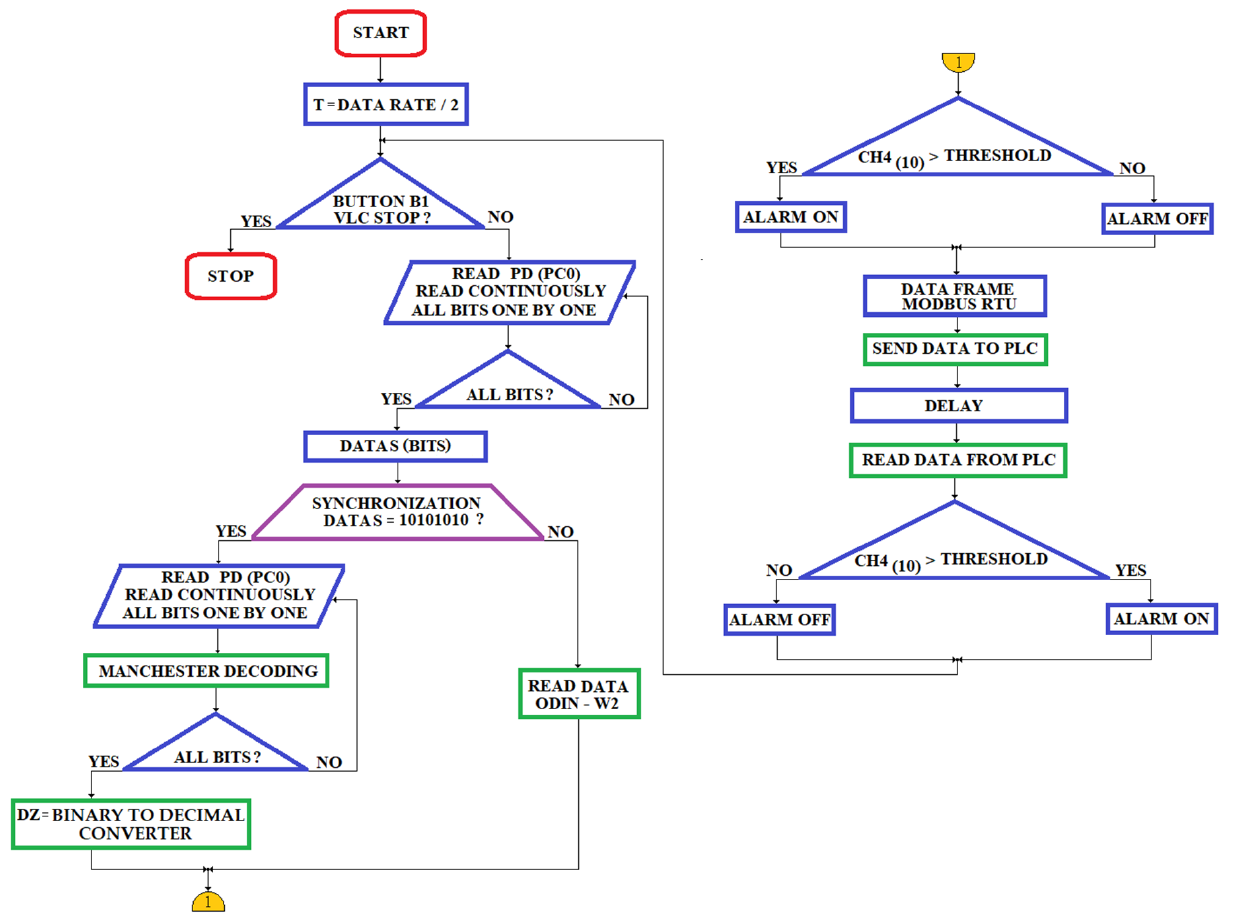
Figure 20. The data reception algorithm of a VLC receiver.